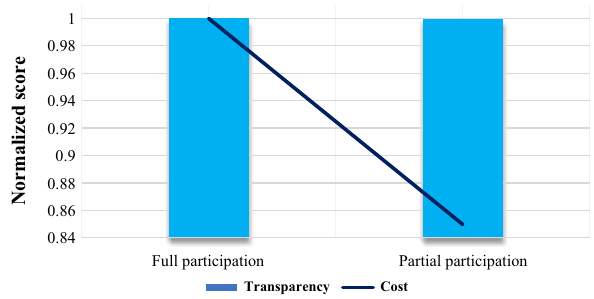
Figure 8. Partial vs. full participation of members in the blockchain.